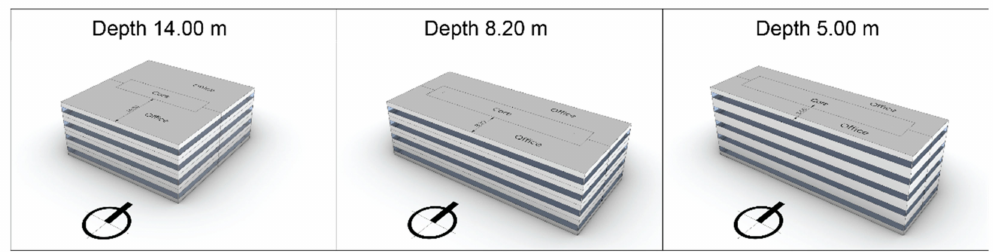
Figure 9. Case study building 1: Basic massing alternatives. Left : Deep offices (14 m); Middle : Standard depth (8.2 m); Right : Shallow depth (5